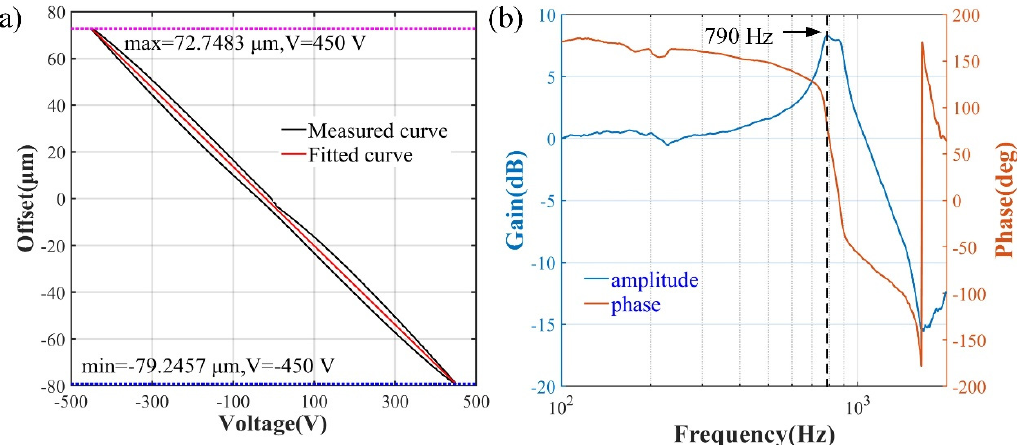
Figure 5. The performance of micro-displacement driving device: ( a ) offset range of the optical fiber bundle as the function of applied driving voltage; ( b ) frequency response curve.